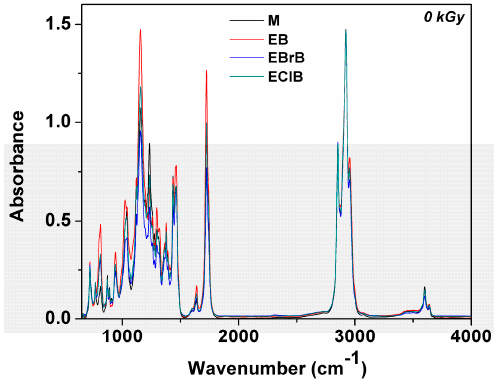
Figure 11. FTIR spectra of nonirradiated EPDM/butyl rubber composites.